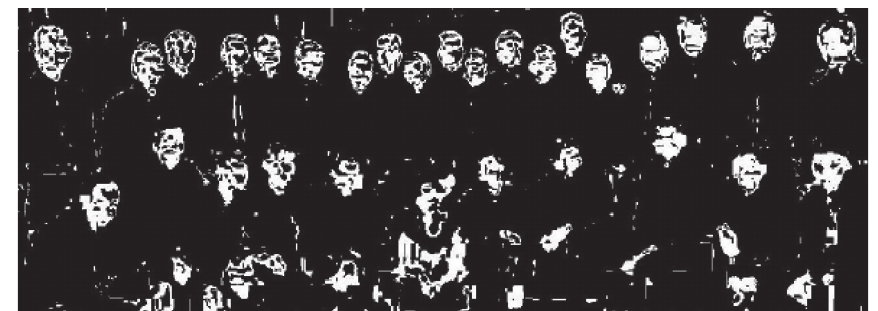
Figure 8: The binary image after skin-color segmentation.